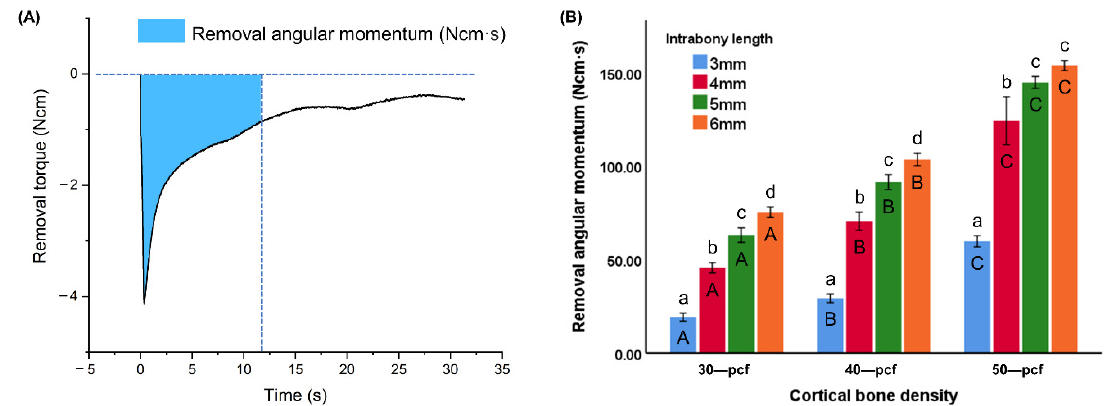
Figure 7. ( A ) Removal torque over time with removal angular momentum (blue). ( B ) Removal angular momentum (RAM) of miniscrews at different intrabony lengths in varying cortical bone densities. Different uppercase letters indicate a significant difference between the miniscrews inserted into cortical bone of various densities ( p < 0.05), while different lowercase letters indicate a significant difference between the miniscrews at the various intrabony lengths ( p < 0.05).